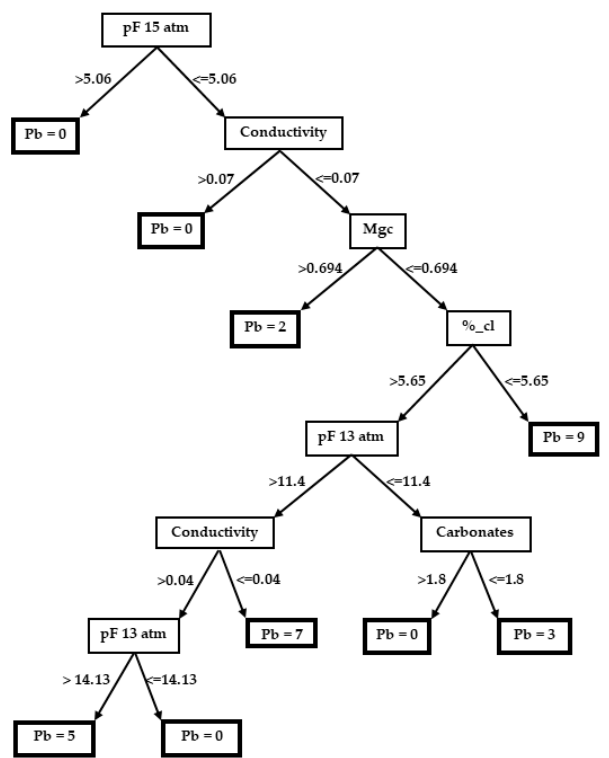
Figure 3. Decision tree for Pb = Plantago bellardii All. The numbering inside the boxes represents the abundance–dominance index converted to Van der Maarel [40]. The other numbering corresponds to the range of values of the edaphic attributes.